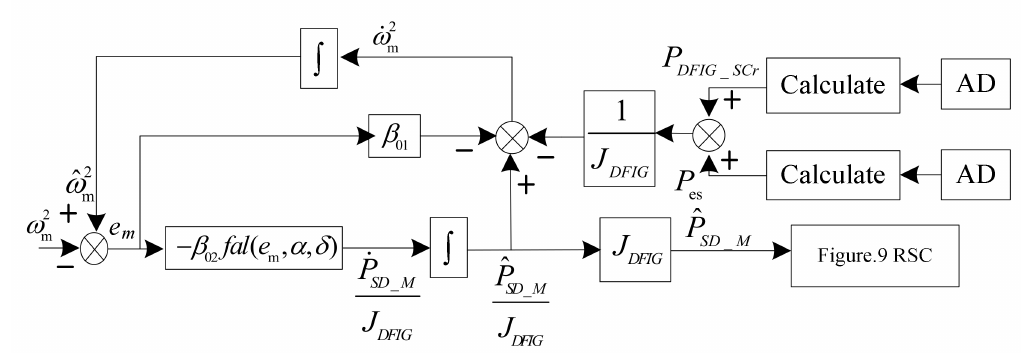
Figure 3. Operational principle of ESO-A. AD: